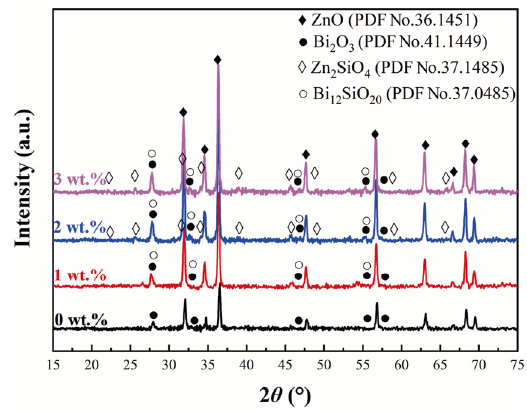
Fig. 3 XRD patterns of flash-sintered samples with different SiO 2 -doped content under the electrical field of 300 V  cm –1